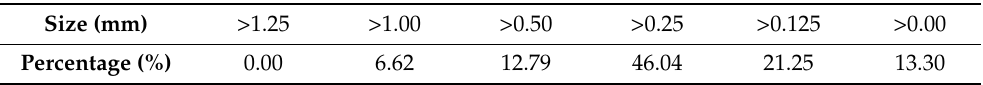
Table A1. Particle size distribution of WS after crushing in mortar and pestle, then sieving (Plansifter MLUA, Bühler, Beilngries, Germany, n =